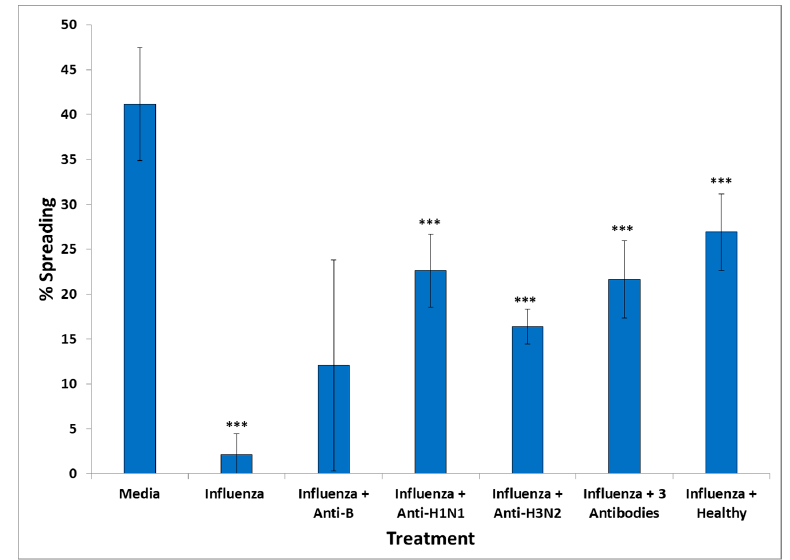
Figure 5. Effect of influenza vaccine, and influenza vaccine incubated with antibodies to influenza vaccine components, H1N1, H3N2, and B strains or without the influenza vaccines on N2A cell spreading. *** p < 0.0001 (compared to medium).